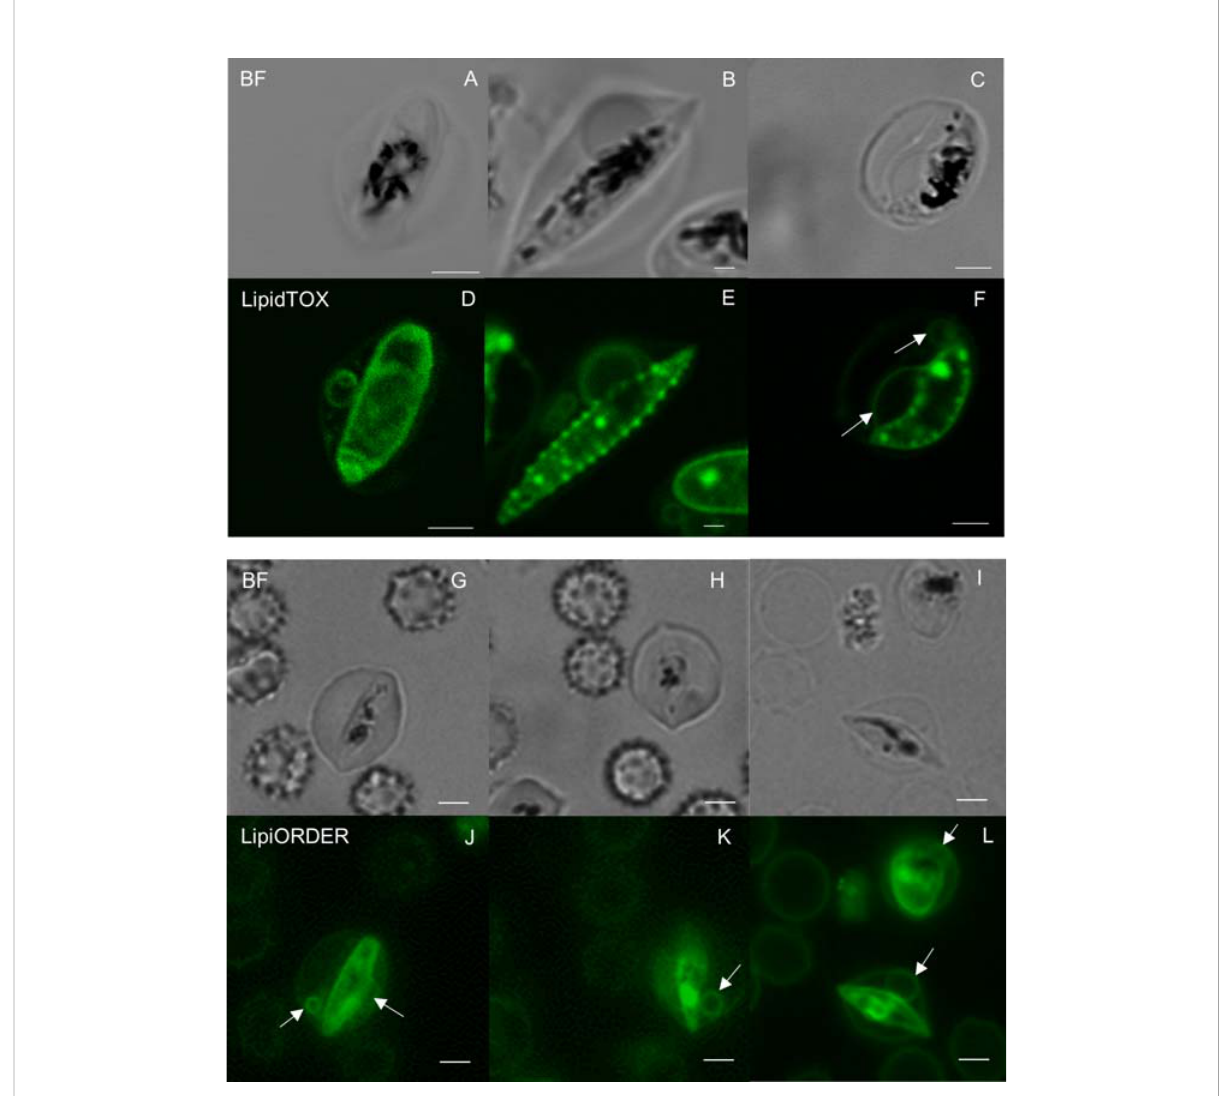
FIGURE 1 Fluorescence microscopy analyses of gametocyte membranes (A – C, G – I) Bright fi eld and (D – F) neutral lipid staining images of gametocytes show multiple annular-neutral lipids in the cytosol of Plasmodium falciparum – infected erythrocytes. The largest size of circular membranous structures was approximately 4 µm in (F) . Membrane lipid staining images also indicate the presence of similar structures by LipiORDER staining (J – L) . The white arrows show lipid membranes. Scale bar = 2.5